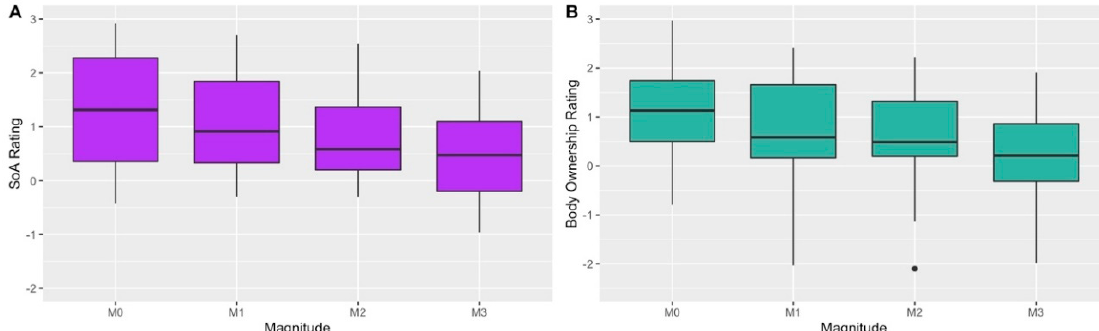
Figure 2. Subjective ratings of SoA (i.e., “I felt as if the movement presented was my own?”; Panel ( A )) and body ownership (i.e., “I felt as if the hand presented was my own?”; Panel ( B )) in